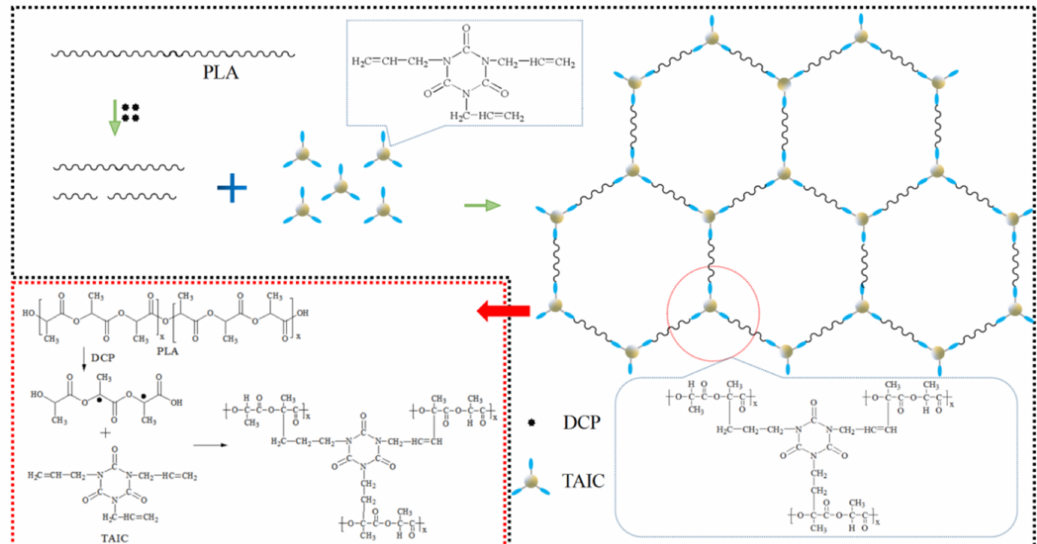
Figure 8. The formation of cross-linked structure in flame-retardant PLA composite under the action of DCP and